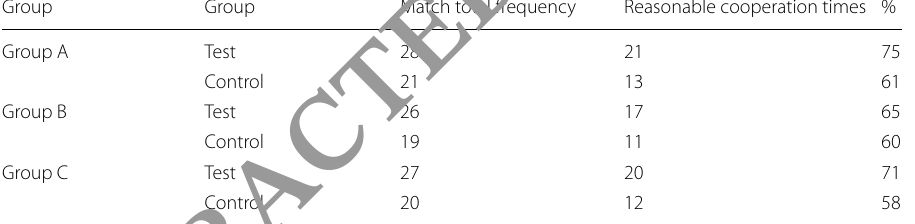
Table 4 Experimental results of teaching competition